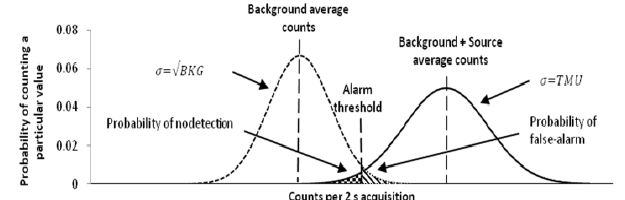
Fig. 16. Detection probability of the tested setup with a bare source of U 3 O 8